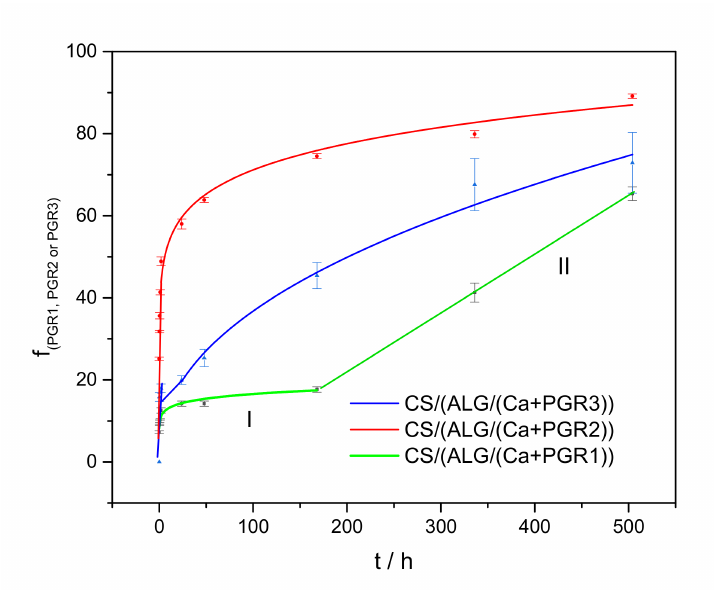
Figure 4. The fraction of released PGRs (f (PGR1, PGR2, or PGR3) with time from microcapsule formula- tions CS/(ALG/(Ca+PGR)): I—the first time interval, II—the second time